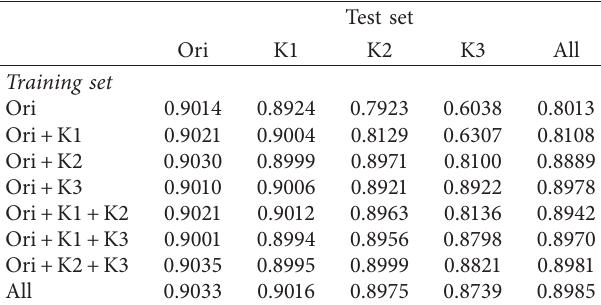
Table 2: Test results on Gaussian